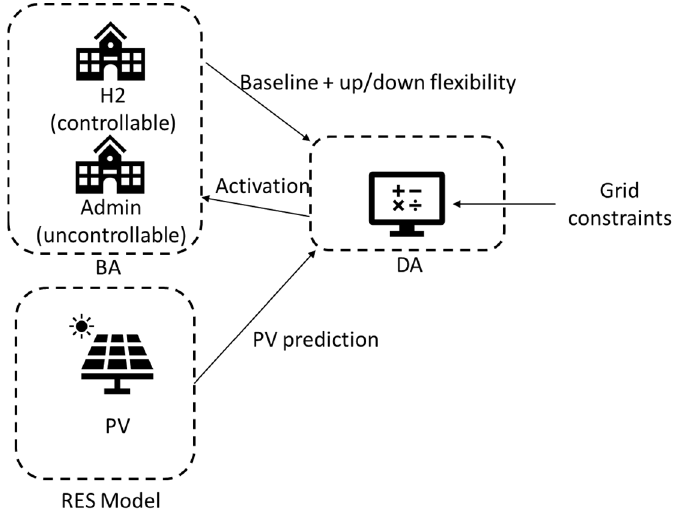
Figure 6. Schematic of the LTCP site district.